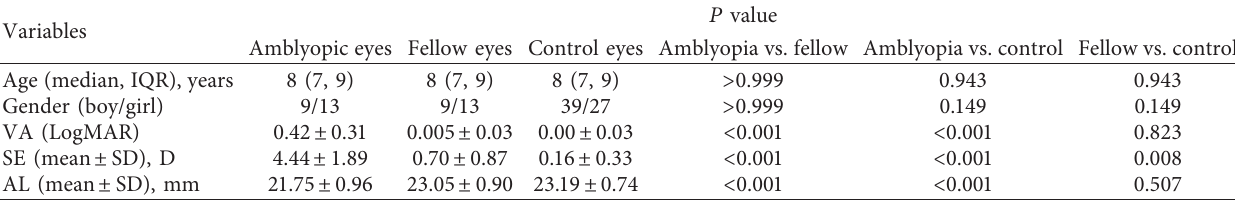
Figure 1: Optical coherence tomographic angiography scans of the macular microvasculature. Representative central 3 × 3mm macular scans of the superficial capillary plexus from an (a) amblyopic eye and (b) fellow eye. Macular vessel density was separately calculated for the fovea and the parafovea as well as the temporal, superior, nasal, and inferior parafoveal quadrants based on the Early Treatment Diabetic Retinopathy Study contour. Table 1: Demographics and biometrics of patients and controls at